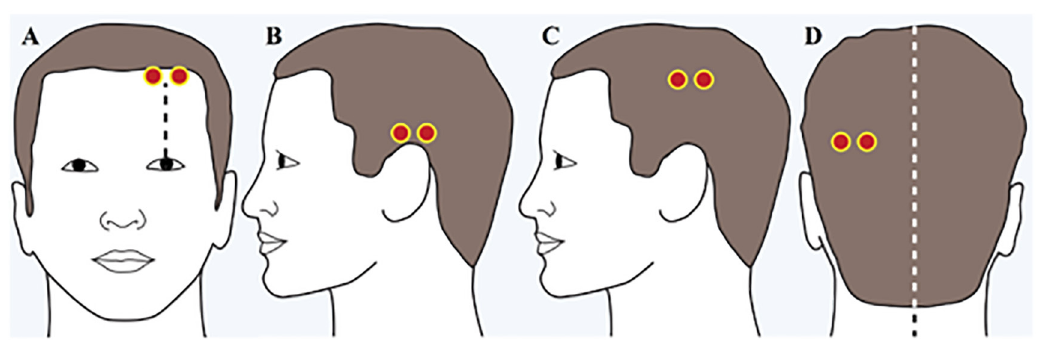
Figure 1. Standardized measurement locations for the handheld brain scanner